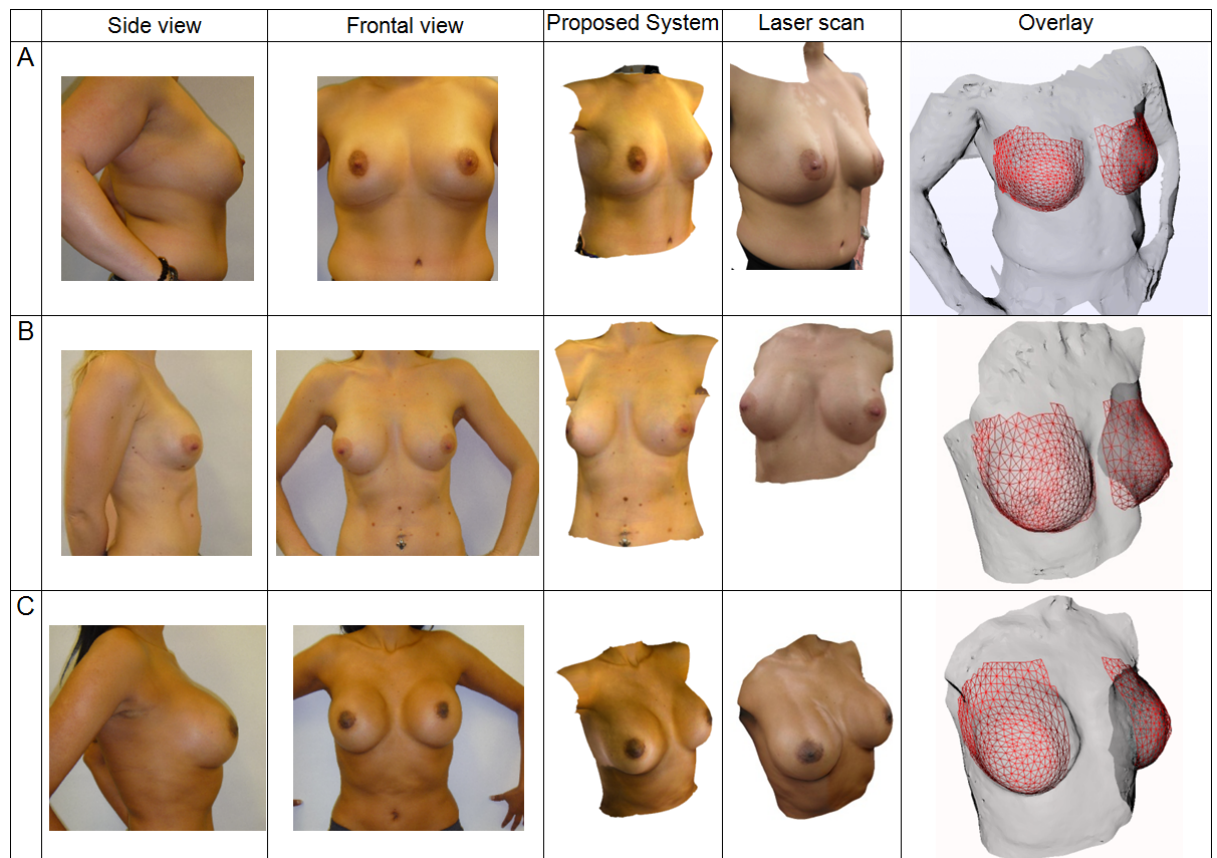
Figure 7. Composite figure sets showing, from left to right: patient photographs, corresponding 3-dimensional (3D) surface reconstruction, laser scan ground truth, and overlaid reconstructed surfaces. The laser scan textures were acquired in the absence of flash photography; hence, their illumination appears slightly different from that in the patient photos. The laser scan surface is shown as a transparent surface in the last column, and the 3D reconstruction is displayed as a superimposed red wire frame. The preoperative simulated images are screenshots from the Web-based interface, as seen in the Proposed System